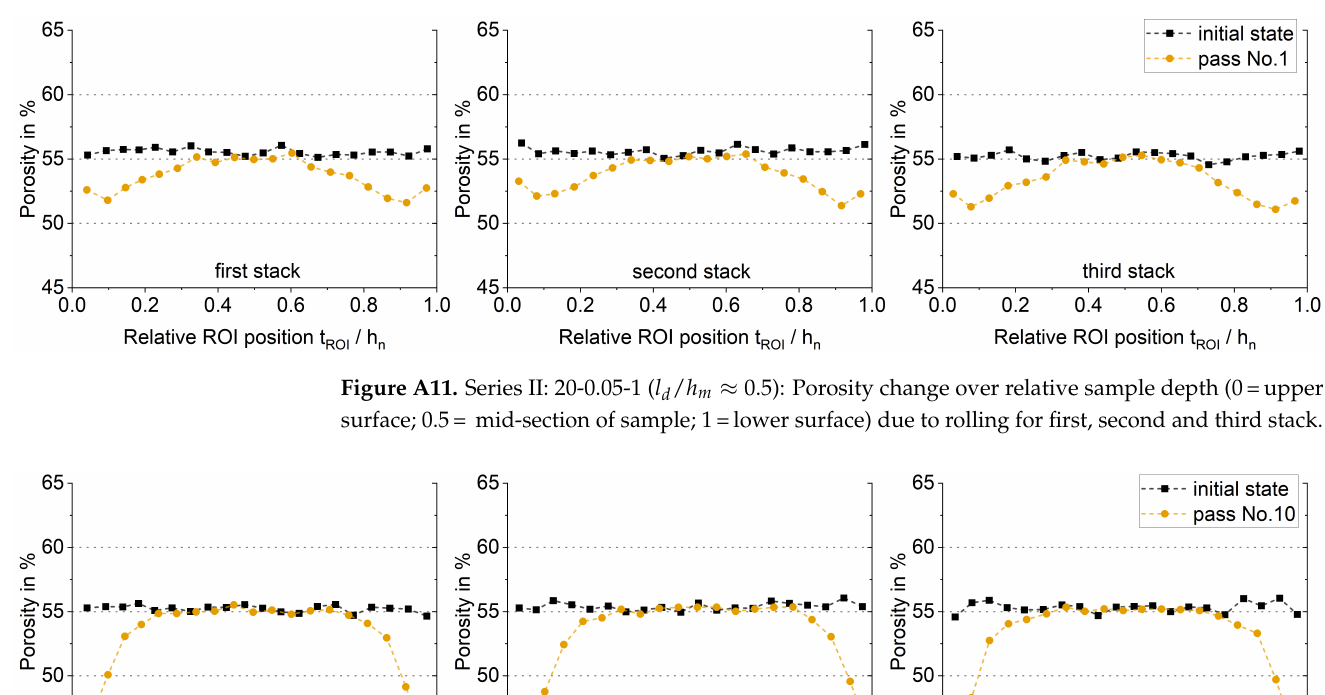
Figure A10. Series II: 20-0.50-20 ( l d / h m ≈ 0.5): Porosity change over relative sample depth (0=upper surface; 0.5= mid-section of sample; 1 =lower surface) due to rolling for first, second and third stack.